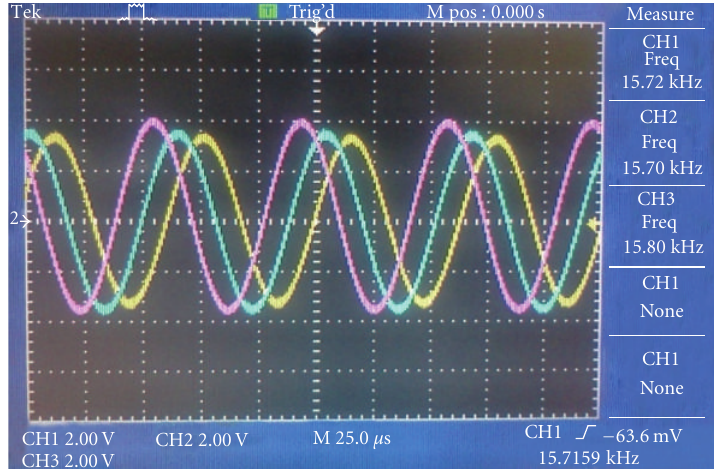
Figure 10: Experimental result for circuit II for n =